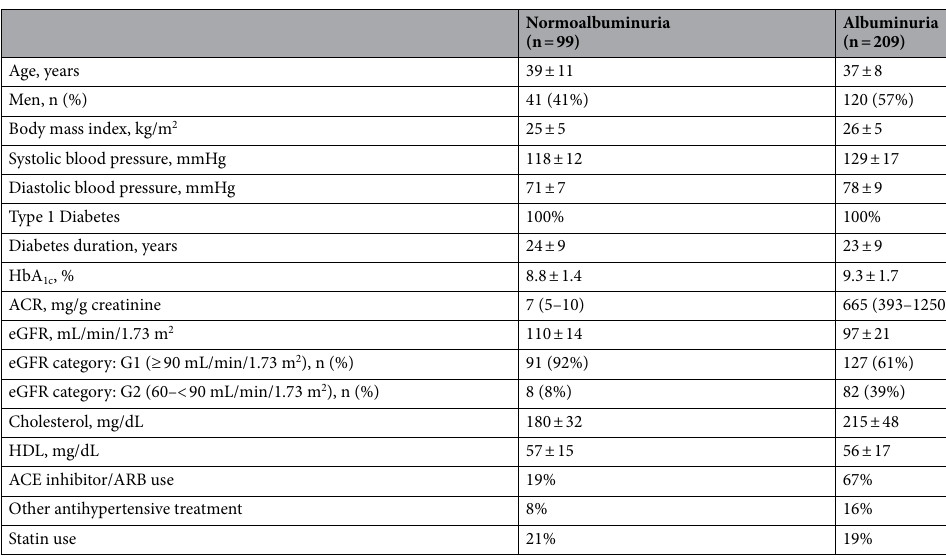
Table 1. Clinical characteristics of the study population. Study subjects had long duration of Type 1 Diabetes, normal renal function, and persistent normoalbuminuria or a broad range of albuminuria. ACR albumin to creatinine ratio, HbA 1c hemoglobin A 1c , eGFR estimated glomerular filtration rate, HDL high density lipoprotein, ACE angiotensin-converting enzyme, ARB angiotensin II receptor blocker, n sample size. Continuous traits are presented as mean (± SD) or median (25th–75th percentile), and binary traits are presented as %. Classification of eGFR followed the guidelines set by NKF/KDIGO 57